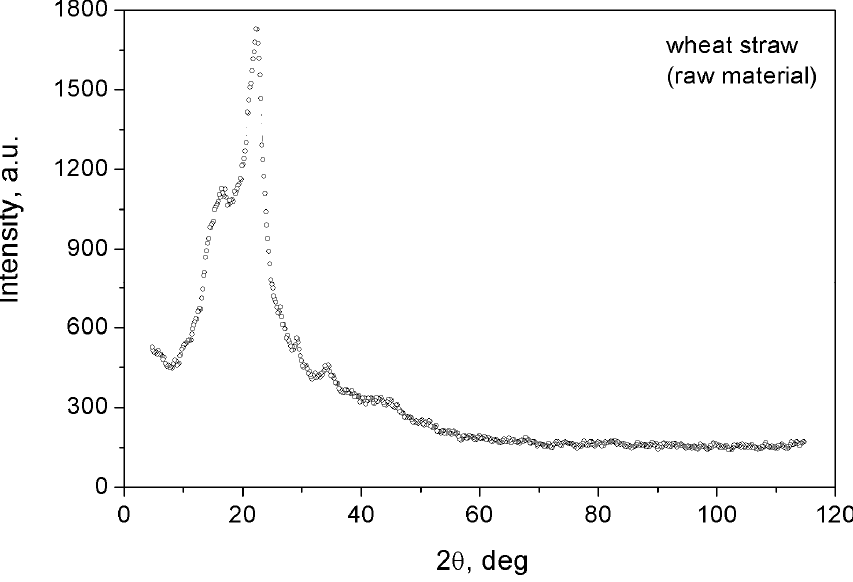
Figure 2. X-ray diffraction pattern of the raw material.